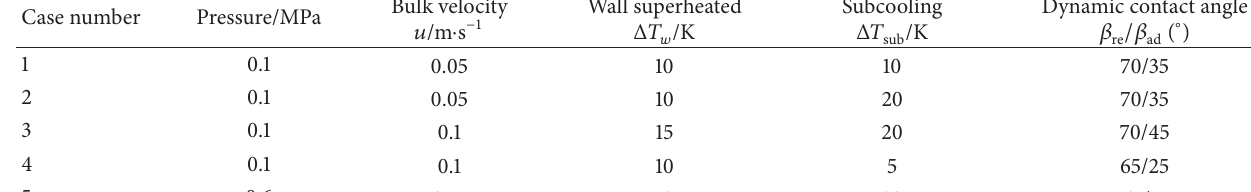
Table 1: Typical working condition.